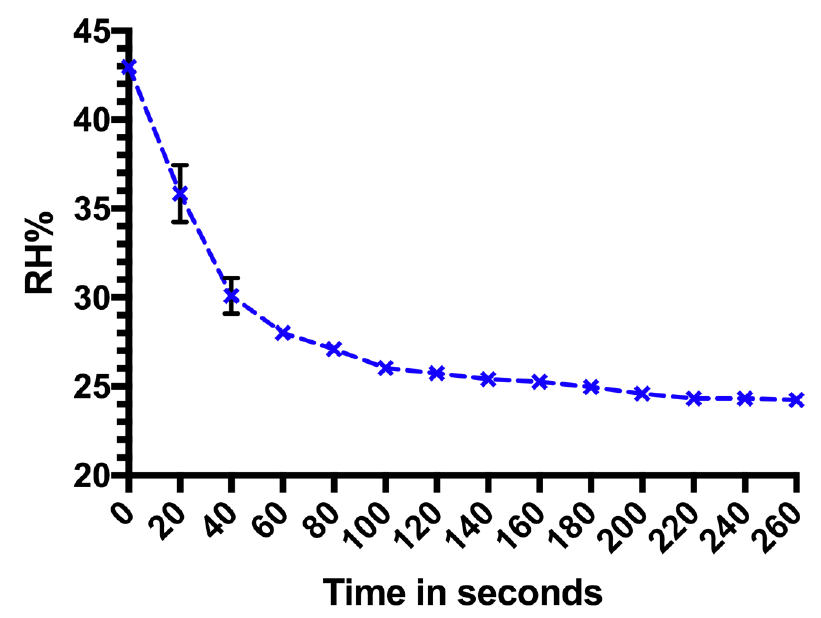
Figure 3. Time taken for RH% to revert from the RH% achieved using K 2 CO 3 to the initial RH% after removing the lid from the test chamber after the experiments with 256 cm 2 of saturated salts. Data points are pooled from three repeats and error bars (where visible) represent standard deviation.